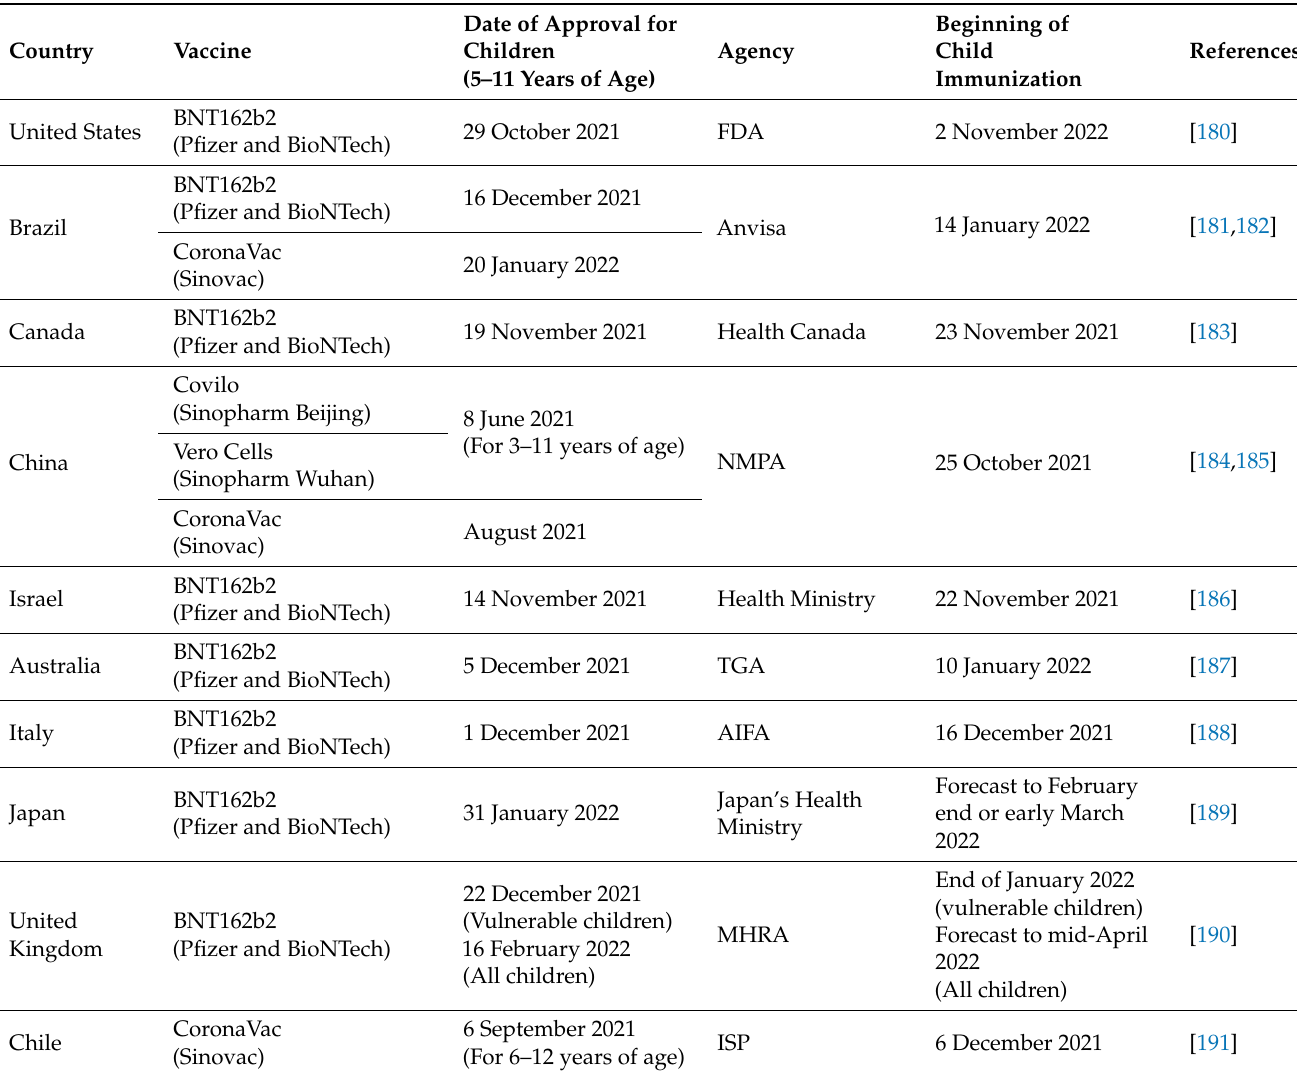
Table 3. Vaccines approved for children immunization